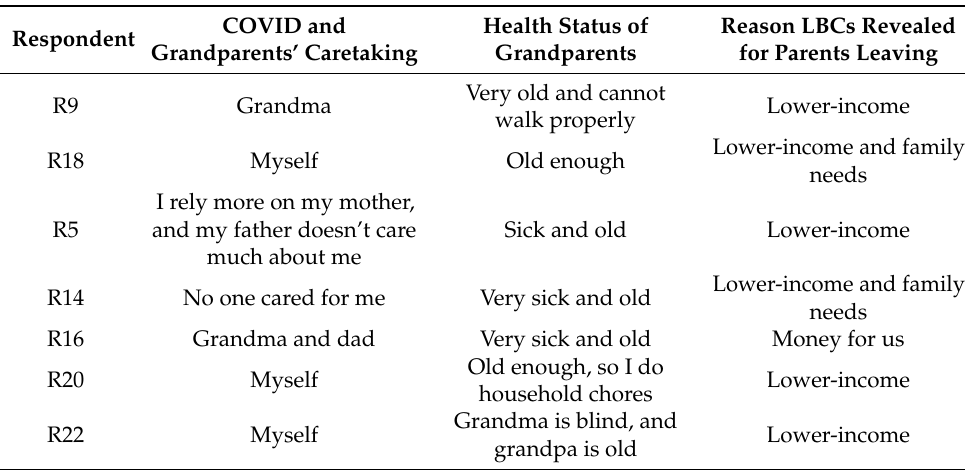
Table 5. LBC and their legal guardians’ caregiving.